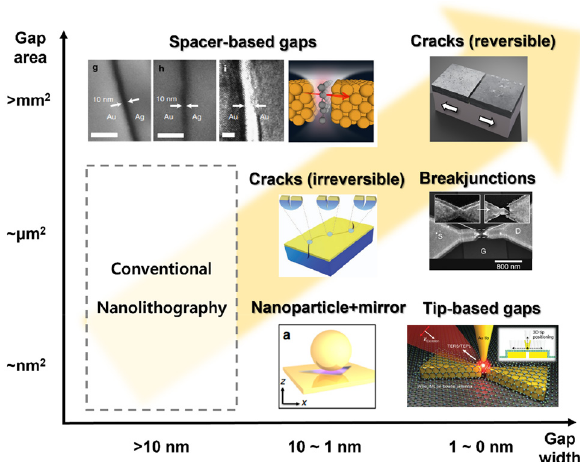
Figure 1: An overview on various types of metallic gaps depending on minimum achievable gap widths and capability of fabrication overalargearea.Reproducedwithpermissionfrom[25,26](Spacer- based gaps) [27], (cracks – reversible) [28], (cracks-irreversible) [29], (breakjunctions) [30], (nanoparticle + mirror) [31], (tip-based gaps).